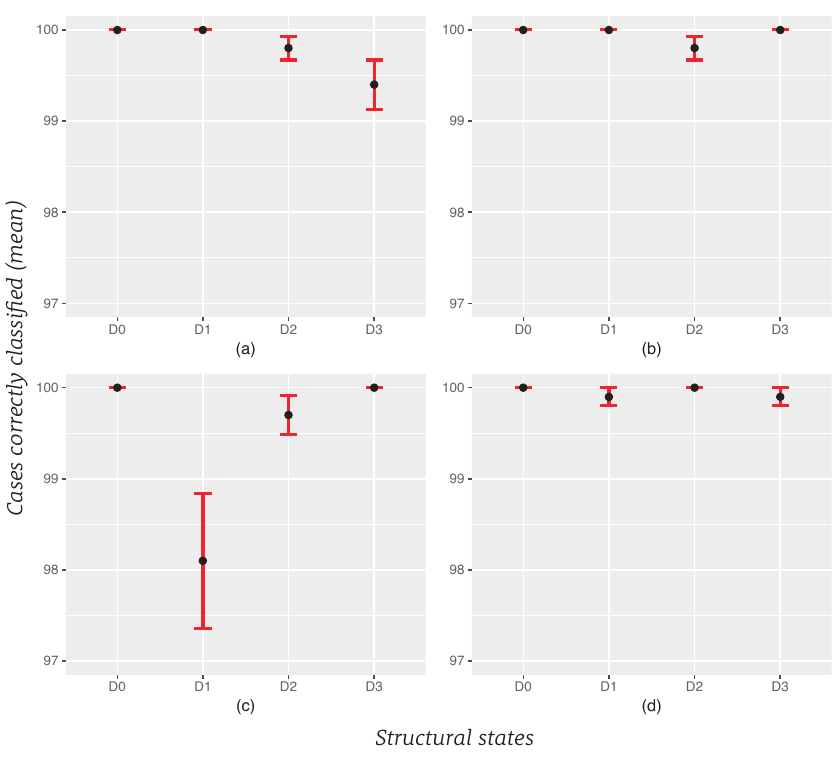
Figure 5. Repeatability of the SHM strategy (10 times), graphs with error bars: ( a ) scenario 1 and majority voting approach; ( b ) scenario 1 and sum of the inverse distances approach; ( c ) scenario 2 and majority voting approach; ( d ) scenario 2 and sum of the inverse distances approach. D 0: healthy state of the structure; D 1, D 2, and D 3: added masses at the positions indicated in Figure 4. Table 9. Repeatability of the SHM strategy (10 times): scenario 1 and majority voting approach. D 0: healthy state of the structure; D 1, D 2, and D 3: added masses at the positions indicated in Figure 4.